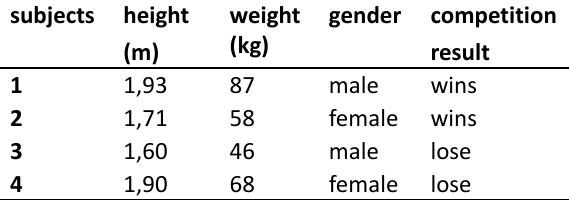
Table 6. Characteristics of the subjects studied subjects